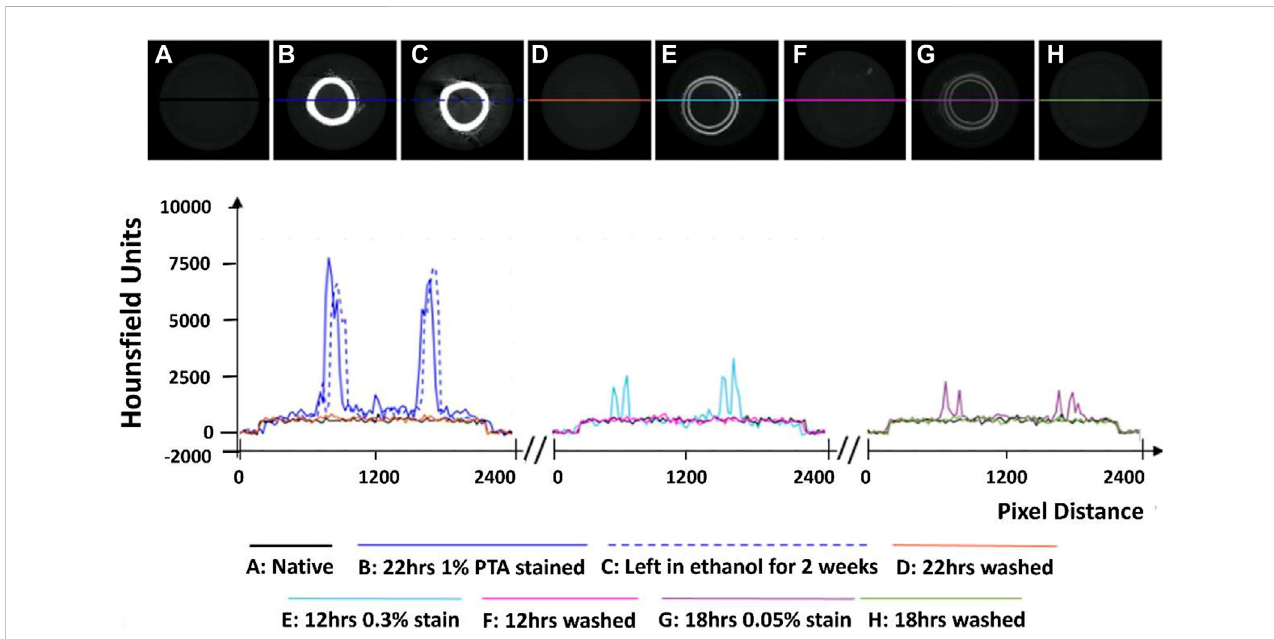
FIGURE 1 EstablishmentoftheoptimumconcentrationforPTApenetrationthrougharterialtissuesamples. (A) Nativecontrol (B) Stainedsamplefor22 hat1%PTA (C) Preservation in ethanol for 2 weeks (D) Removal of stain using NaOH for 22 h (E) Stained sample for 12 h at 0.3% PTA (F) Removal of stain using NaOH for 12 h. (G) Stained sample for 18hrs in 0.05% stain. (H) Removal of stain using NaOH for 18